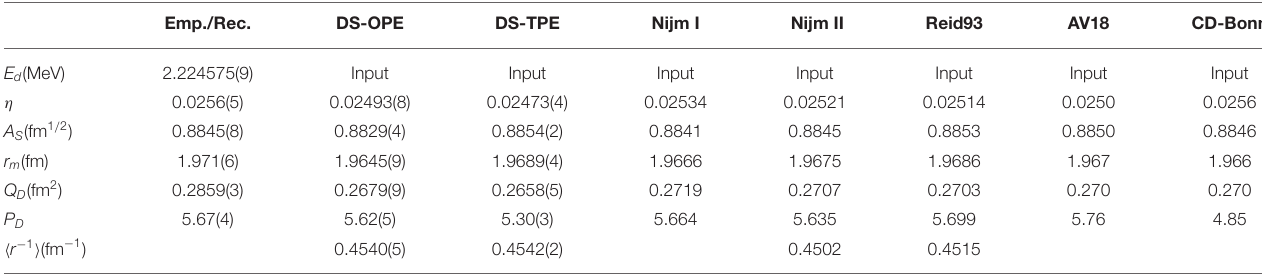
TABLE 10 | Deuteron static properties compared with empirical/recommended values [115–120] and high-quality potentials calculations, DS-OPE [45], DS-TPE [77], Nijm I [16], Nijm II [16], Reid93 [16], AV18 [17], CD-Bonn [18].